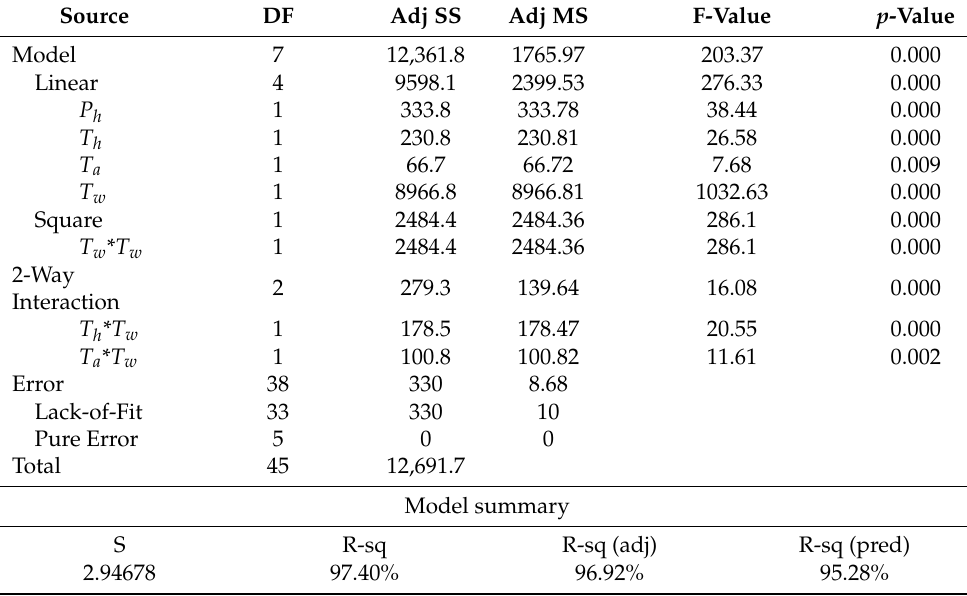
Table 6. Analysis of variance of the back-EMF